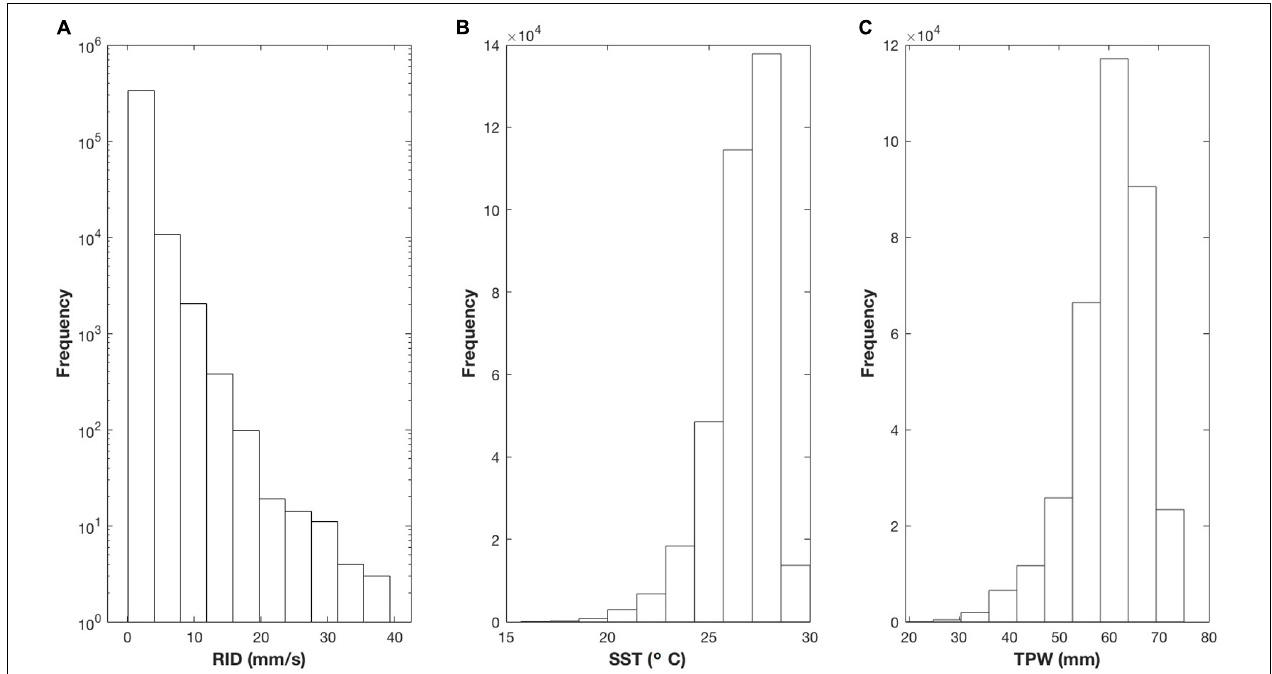
FIGURE 3 | High-resolution data frequency histograms for the studied variables: (A) RID (y-log scale), (B) SST, and (C) TPW from 2009 to